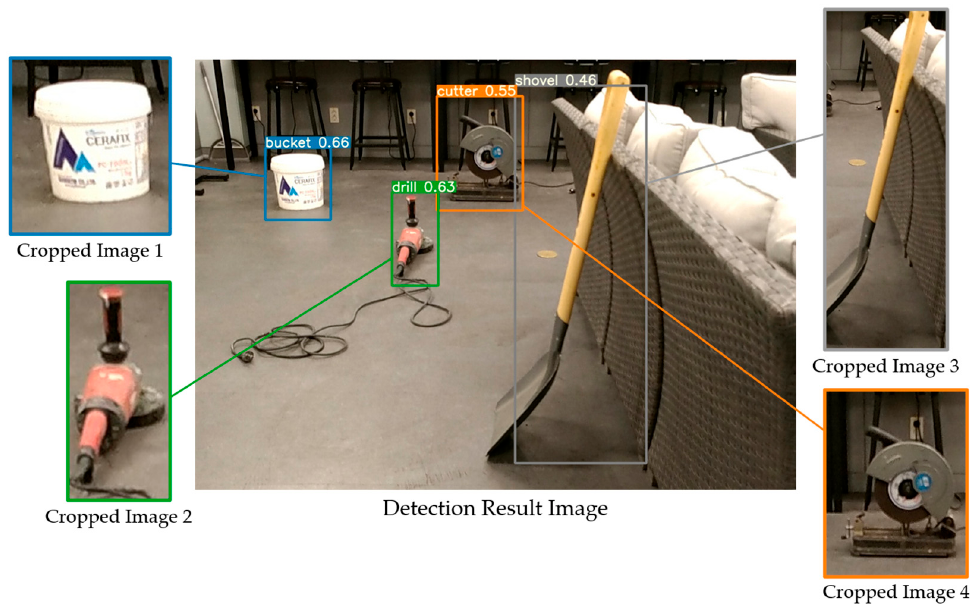
Figure 9. Result of cropped bounding boxes in an image.